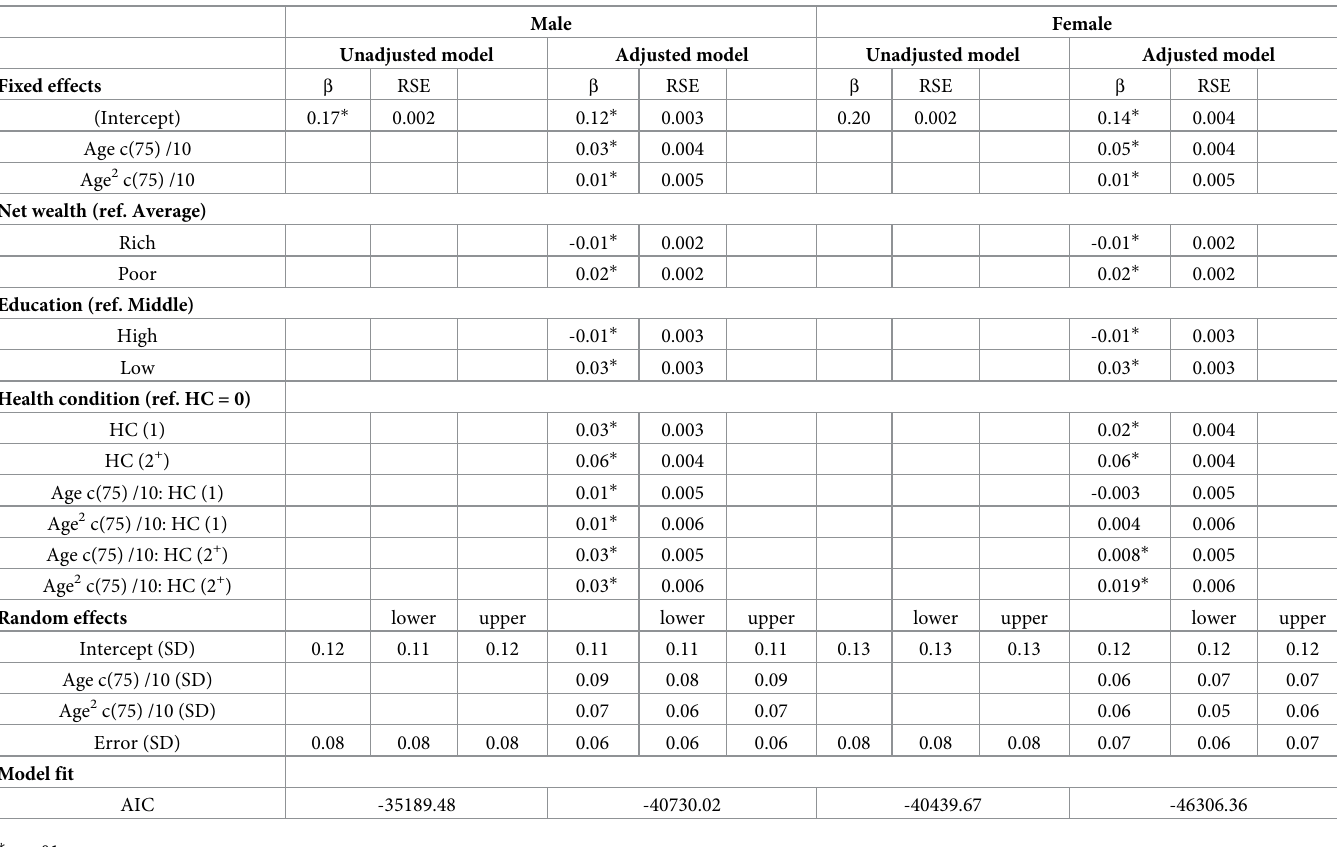
Table 3. Conditional multilevel growth model for FMM for male and